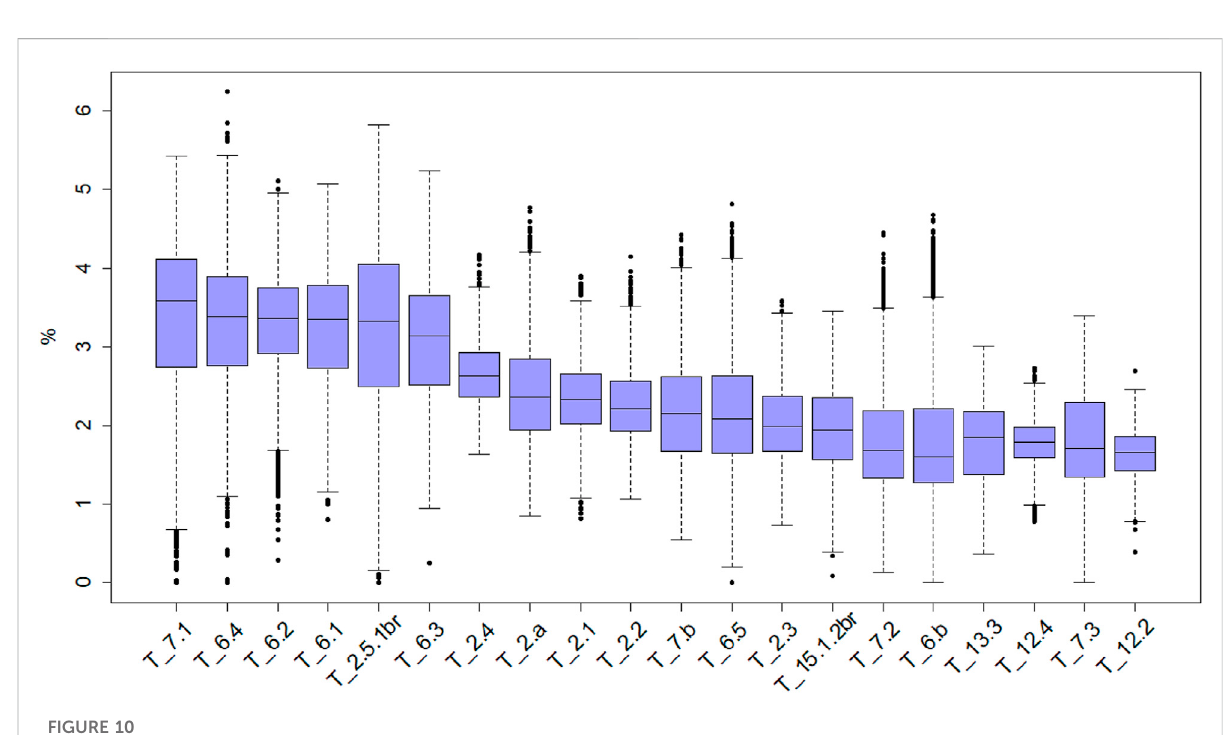
FIGURE 10 Target contribution proportions to the